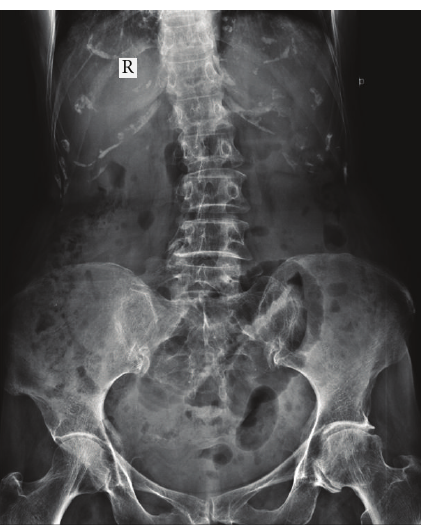
Figure 1: X-ray standing abdomen showing dilated small bowel loops in lower abdomen and pelvis.